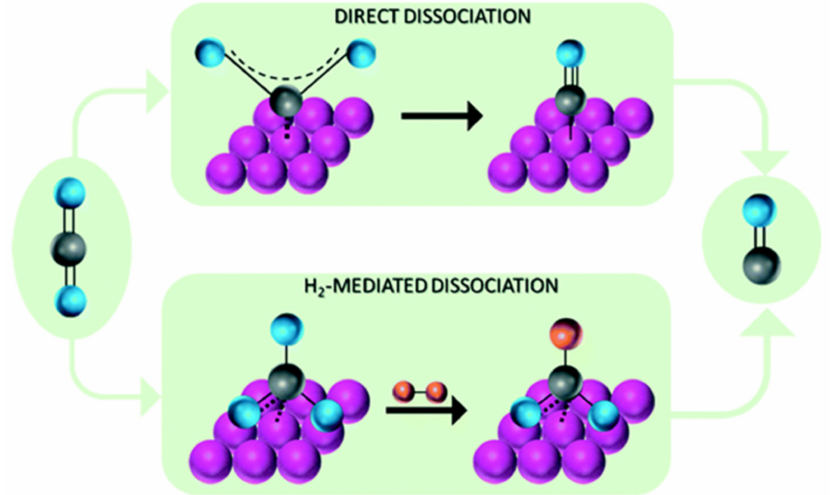
Figure 2. Simple schematic of RWGS mechanism for direct and H-assisted CO 2 dissociation processes, reprinted with permission from [76]. Copyright Royal Society of Chemistry,